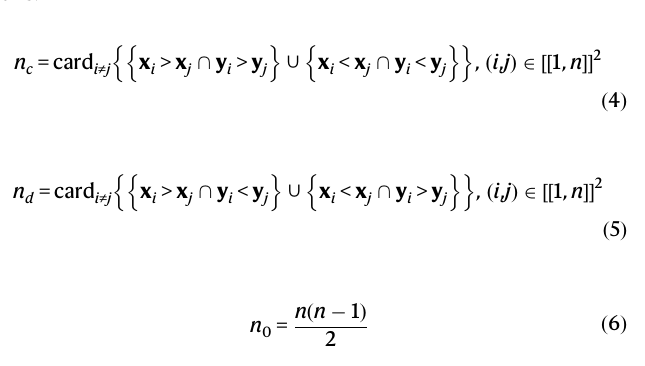
Figure 1b, c: For each grid point, a two-tailed Student test is applied to the regression coef fi cients between the corresponding climate vari- able and the AMV indices. The degrees of freedom are corrected using time series autocorrelations 45 . Figure 6a: The Kendall rank correlation coef fi cient, or Kendall